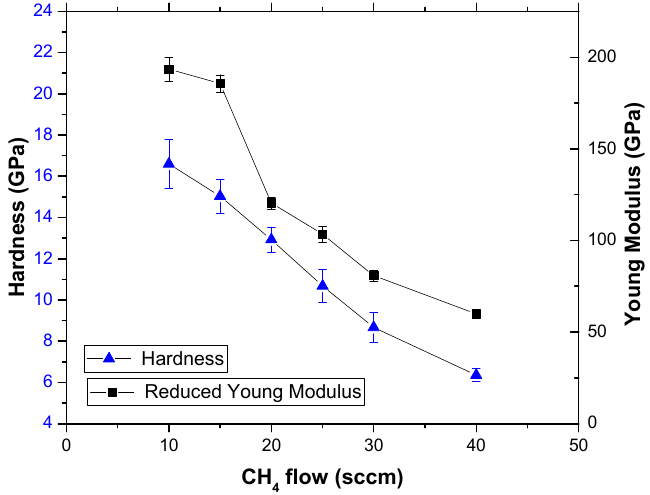
Figure 5. Evolution of the hardness and Young’s modulus with the increase of the CH 4 flow.